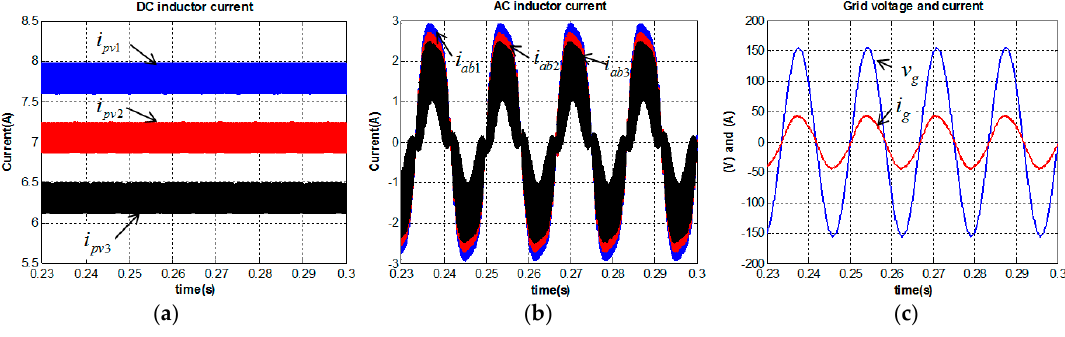
Figure 14. Simulation waveforms using the state-space average model. ( a ) PV currents; ( b ) the output currents; ( c ) grid voltage and current.